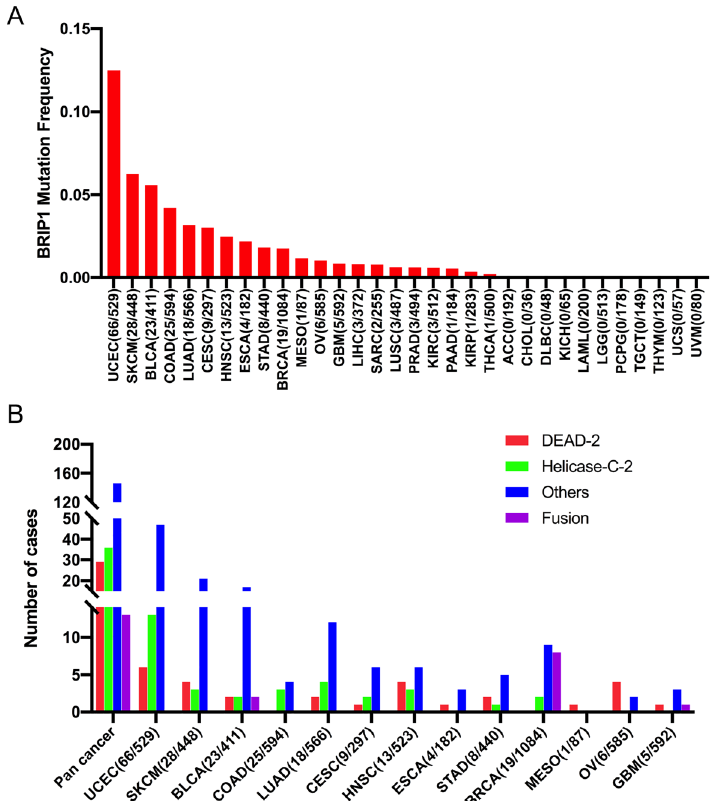
Figure 3. The mutation frequency of BRIP1 in various TCGA cancers and protein functional domains. ( A ) The BRIP1 mutation frequency in 32 TCGA cancer types. ( B ) The mutation location of BRIP1 in BRIP1 protein domains in pan cancer and in the top 13 cancer